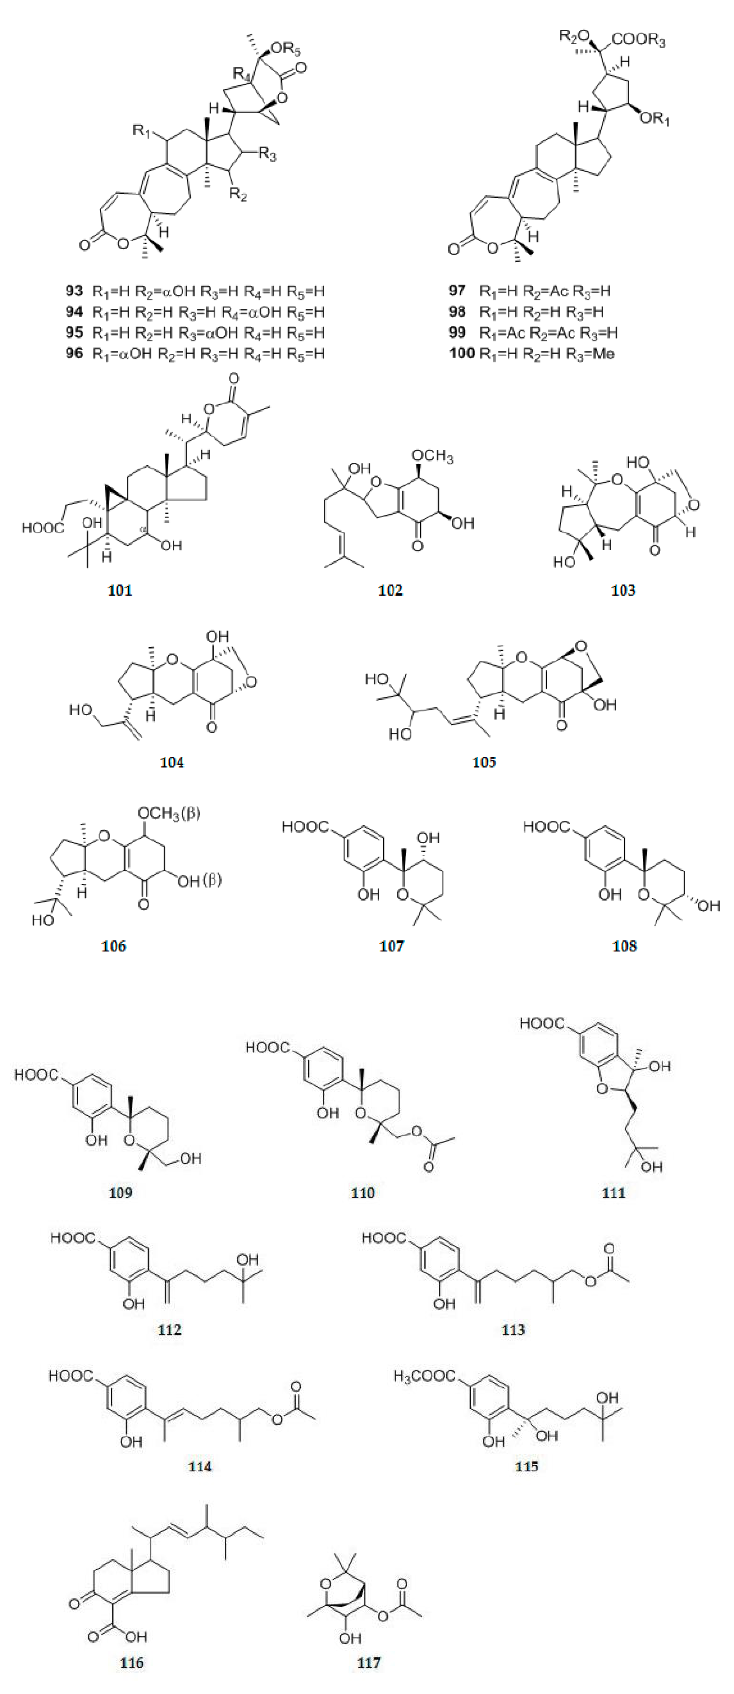
Figure 4. Chemical structures of other terpenoids and derivatives.